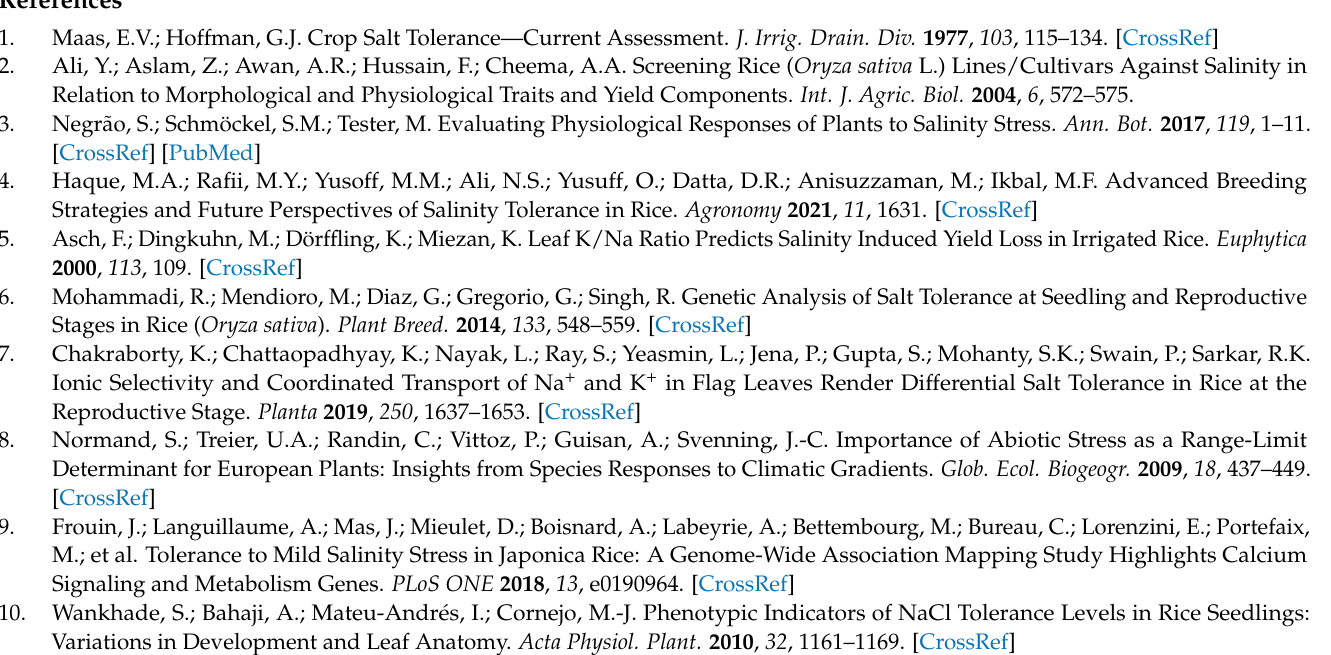
and Parameters, Table S3: Seedling data, Table S4: Seedling Pearson correlation, Table S5: Re- productive_Anova, Table S6: Reproductive dataset, Table S7: Reproductive_Pearson, Table S8: